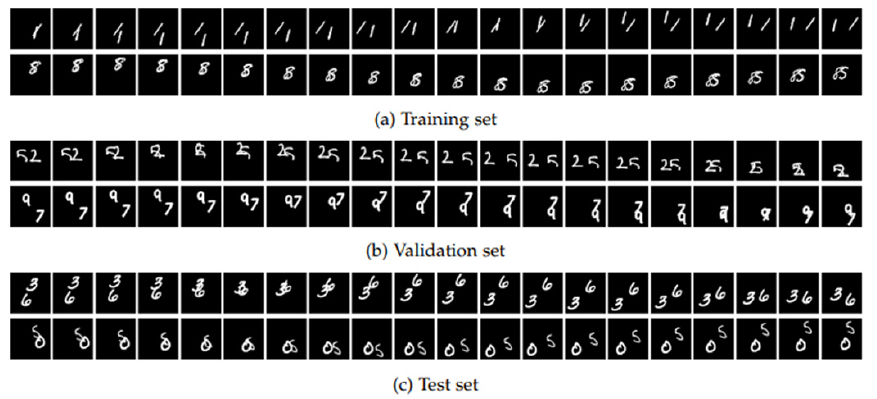
Fig. 5. Randomly chosen samples of generated image sequences of size 64 × 64 from the moving MNIST